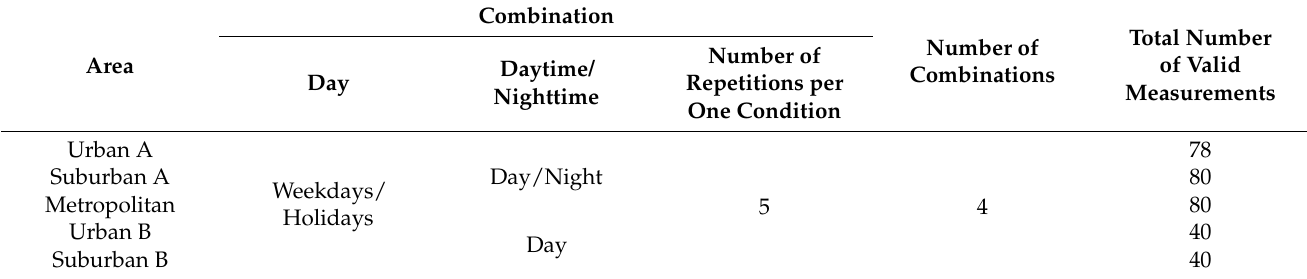
Table 5. Conditions of repeated measurements during May 2021 to February